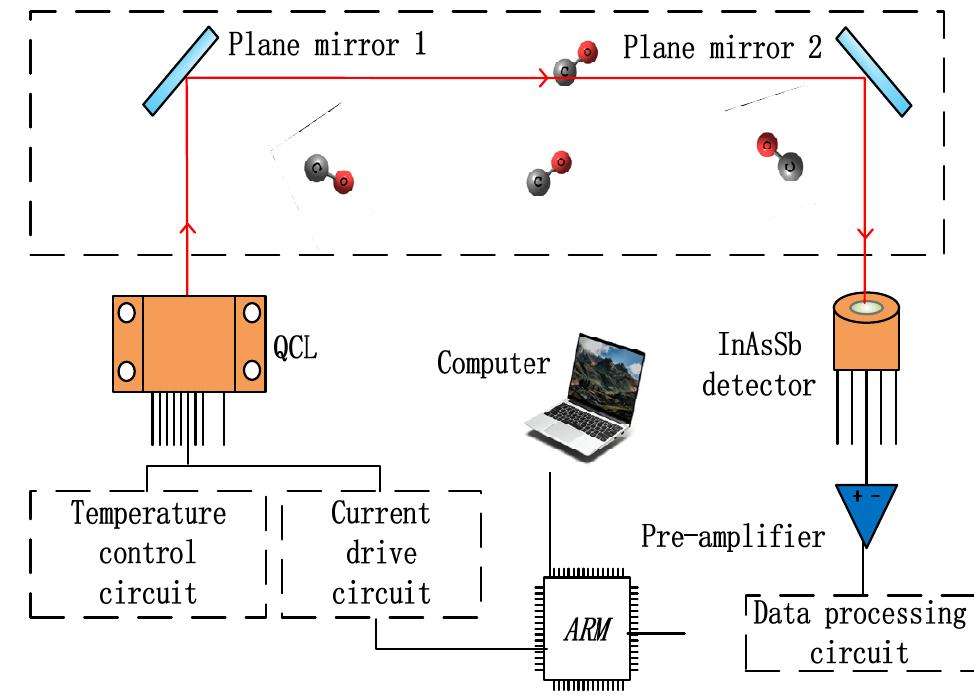
Figure 2. Schematic drawings of the compact and low-power-consumption CO